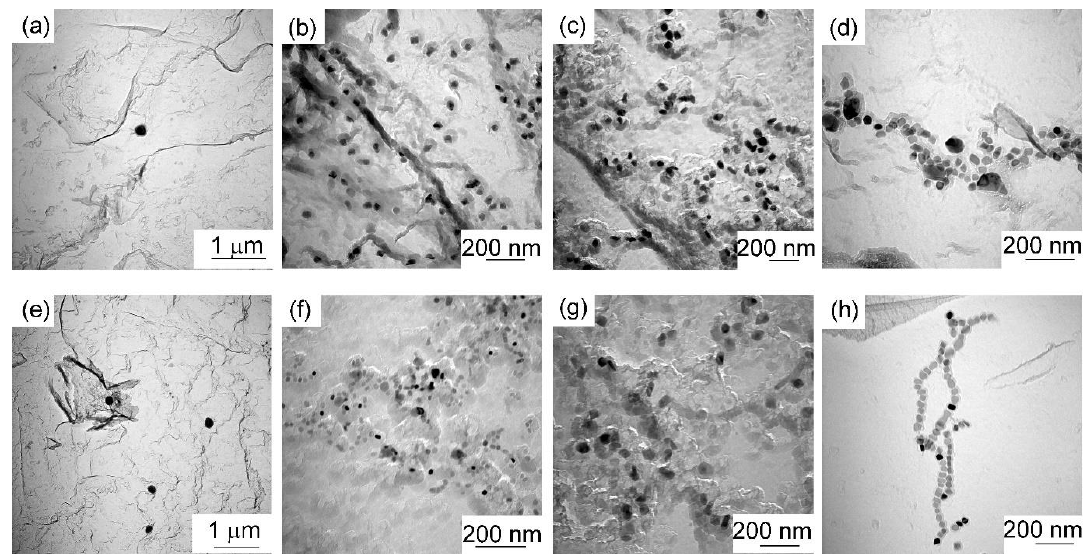
Figure 4. Bright-field (BF) Transmission electron microscopy (TEM) images of the carbon replicas of the Nb ( a – d ) and Nb-Mo ( e – h ) steels heat treated at 900 ◦ C for 100 s, 1000 s, 3000 s, and 10,000 s, from left to right. Note scale bar changes.